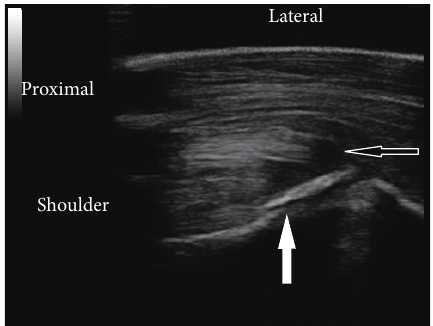
Figure 3: Ultrasound image of the lateral aspect of the greater tubercle of the humerus: a bony fragment (white arrow) associated with the insertion of the infraspinatus tendon (white empty arrow) on the distal aspect of the greater tubercle is visible.